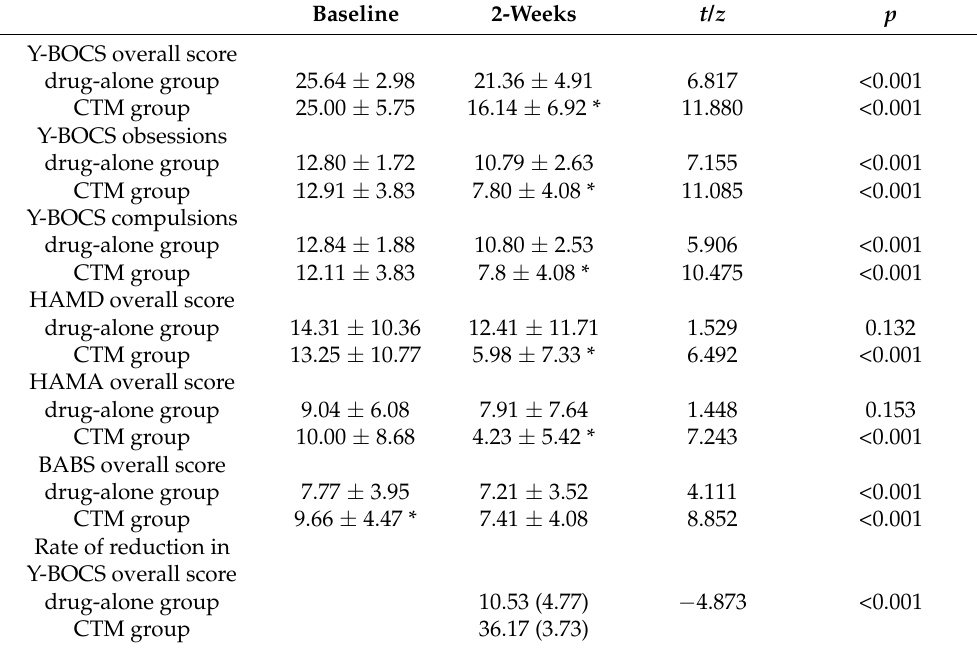
Table 2. Therapeutic outcome assessment and comparison of Y-BOCS, HAMD, HAMA and BABS overall scores before and after treatment between the two groups.